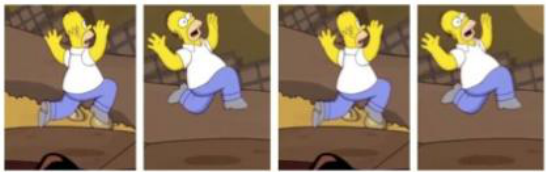
Figure 2. Homer in the Land of Chocolate.